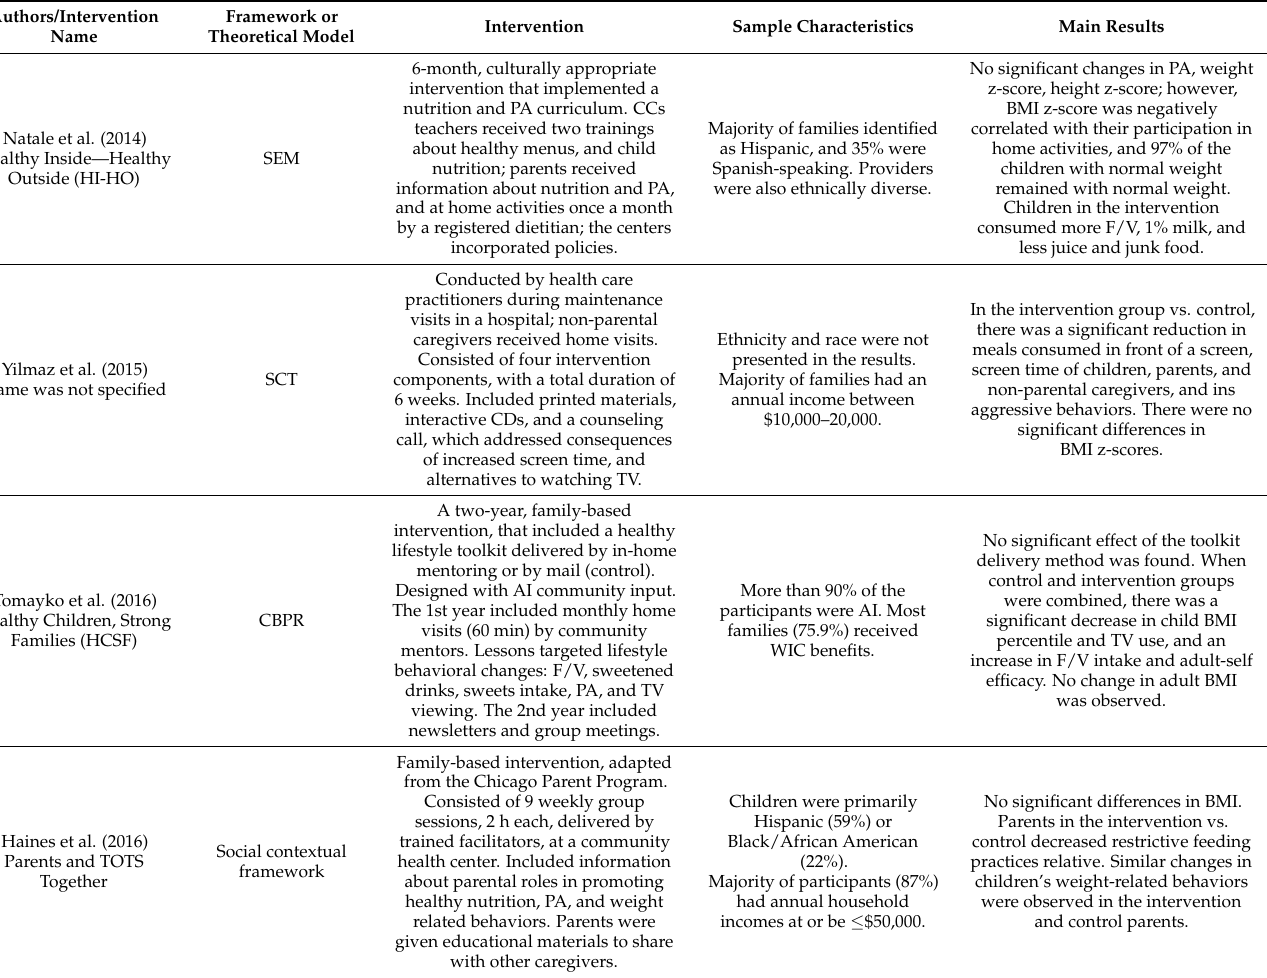
Table 3. Description of the interventions evaluating obesity prevention interventions among children between 0 and three years that included non-parental